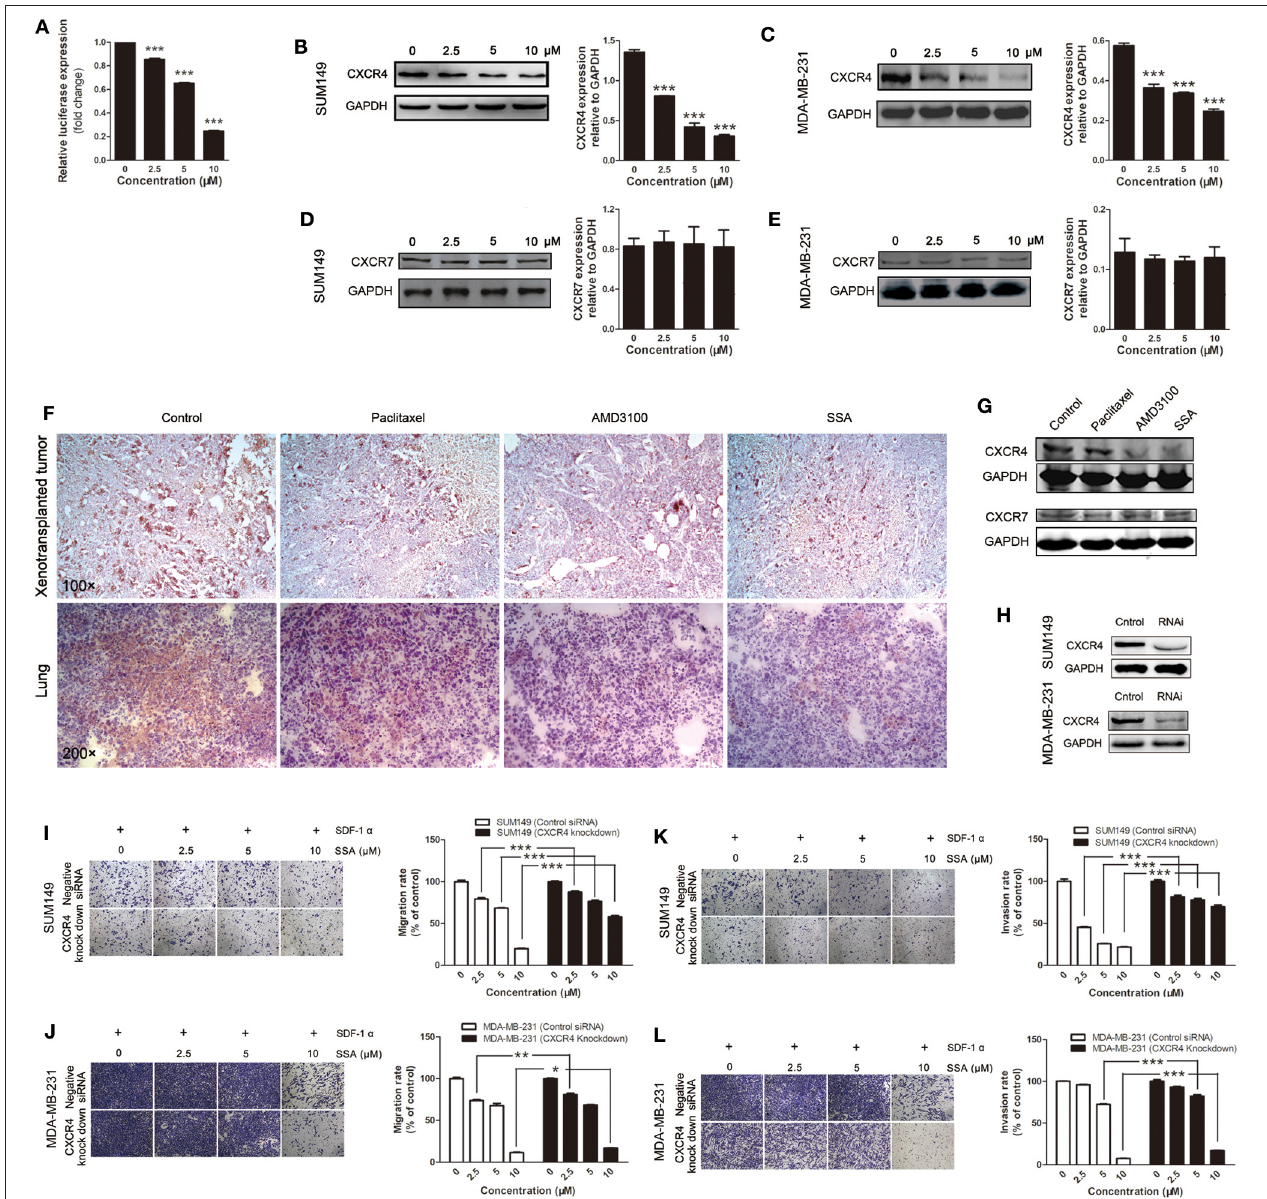
FIGURE 4 | SSA down-regulates CXCR4 to inhibit the migration and invasion of TNBC cells. (A) SSA inactivates the CXCR4 promoter in a concentration-dependent manner. SUM149 (B) and MDA-MB-231 (C) cells were incubated with SSA at various concentrations for 24h. CXCR4 expression of cells was analyzed by Western blot. The histograms on the right of Western blots show the expression levels of CXCR4 in SUM149 and MDA-MB-231 cells. Data from three independent experiments were pooled. *** p < 0.001 vs. 0 µ M of SSA. CXCR7 protein expression of SUM149 (D) and MDA-MB-231 (E) after incubating with SSA at various concentrations for 24h. The histograms on the right of Western blots show the expression levels of CXCR7 in SUM149 and MDA-MB-231 cells. Data from three independent experiments were pooled. (F) Sections of xenografts (upper row) and lung tissue (lower row) in different groups were submitted to immunohistochemistry using antibodies of CXCR4. (G) Western blot analysis detection of the CXCR4 and CXCR7 protein expression in the lung tissue of 4T1-luc mice in different groups. (H) Western blot analysis of CXCR4 protein expression in SUM149 and MDA-MB-231 cells transfected with an siRNA against CXCR4 for 24h. SUM149 and MDA-MB/231 cells were transfected with an siRNA against CXCR4 followed by treatment with SSA for 24h at the indicated concentrations. Transwell (I,J) and invasion (K,L) assays were performed. The independent experiments were performed in triplicate. * p < 0.05; ** p < 0.01; *** p < 0.001 compared with cells transfected with control